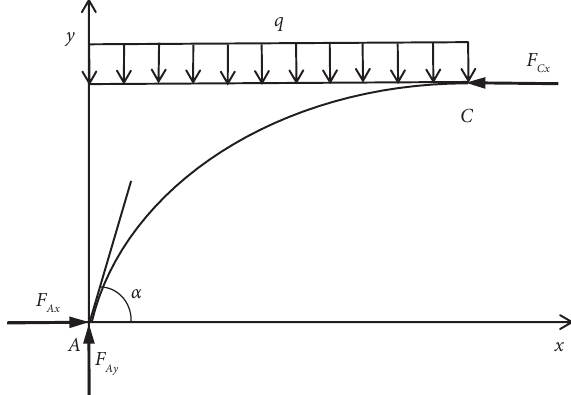
Figure 2: Te force analysis of the soil arch between